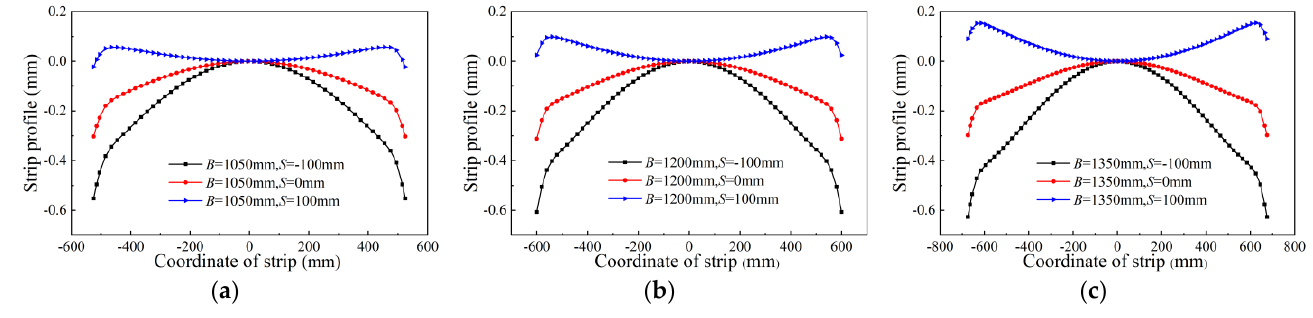
Figure 6. Influence of roll shifting on strip crown. ( a ) B = 1050 mm; ( b ) B = 1200 mm; ( c ) B = 1350 mm. Table 5. Results of the influence of roll shifting on strip crown.